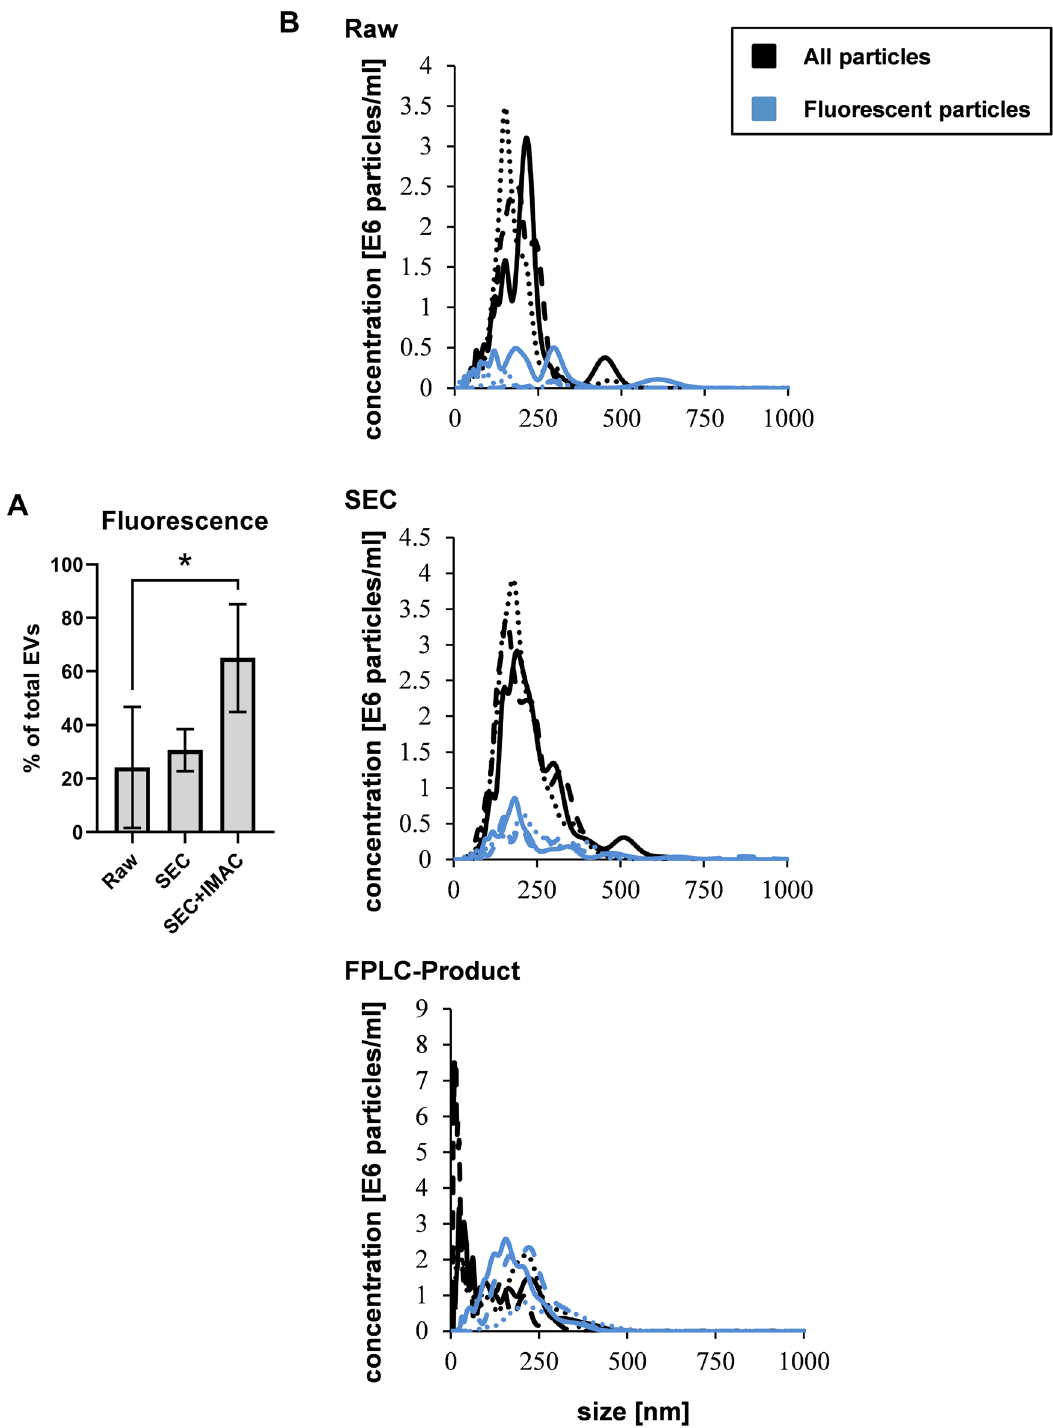
Figure 6. Analysis of fluorescent particles by indirect antibody labelling in NTA. Each preparation step (Raw n = 3, SEC n = 4, SEC + IMAC n = 3) was labelled with anti-FRα-antibody from mouse, washed and then labelled with a secondary antibody conjugated with anti-mouse IgG Alexa Fluor 532. The samples were not further processed but analysed by NTA. ( A ) Quantity of fluorescent particles is expressed as a percentage of the total number of particles. The amount of FRα-positive particles is increasing with each purification step. * = 0.01 < p < 0.05. Data is represented as mean ± s.d. ( B ) The size distribution of one analysis from three independent experiments is depicted as solid, dashed or dotted line. Measurement of all particles are represented in black, while fluorescent particles measurement are represented in